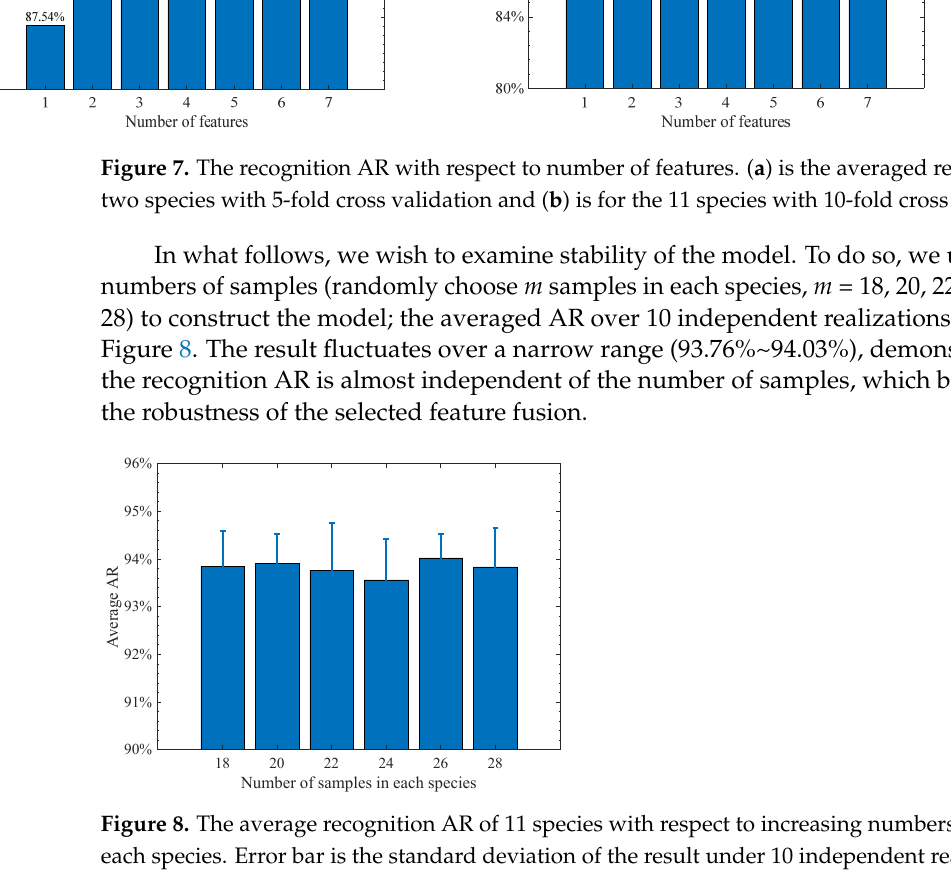
Figure 9. The average recognition AR of 11 species by using three intelligent classifiers. Error bar is the standard deviation of the result under 10 independent realizations. 4. Conclusion and Discussion Recognition of crop varieties with modern intelligent devices is of great significance to the development of smart agriculture. Hyperspectral images are an important and eco ‐ nomic tool for this purpose. In this paper, our task is to identify eleven rapeseed species by using this new tool. To establish the model for identification, we extracted three types of features to obtain their hyperspectral information, namely, the multifractal parameters of hyperspectral reflectance, trilateral parameters of hyperspectral reflectance, and color/texture feature of the hyperspectral image. With the so ‐ called index I 0 , three optimal features MF ‐ ℎ(cid:4666) 0 (cid:4667) , IMF ‐ 𝑆𝑖 / 𝐼 1 , TRIP ‐ 𝐷 (cid:3045)(cid:3040)(cid:3036)(cid:3041) were screened and fused together to act as a model input. The support vector machine kernel method and random decision forest were employed as classifiers. The recognition model was constructed to identify two rapeseed species and another 11 species. K ‐ fold cross validation is used for training and testing the models. The average recognition accuracy rate is 96.35% for the first model (with 5 ‐ fold cross validation) and is 93.71% for the recognition of the 11 other species (with 10 ‐ fold cross validation), respectively. The model test demonstrates that our method has satisfac ‐ tory recognition accuracy and robustness.